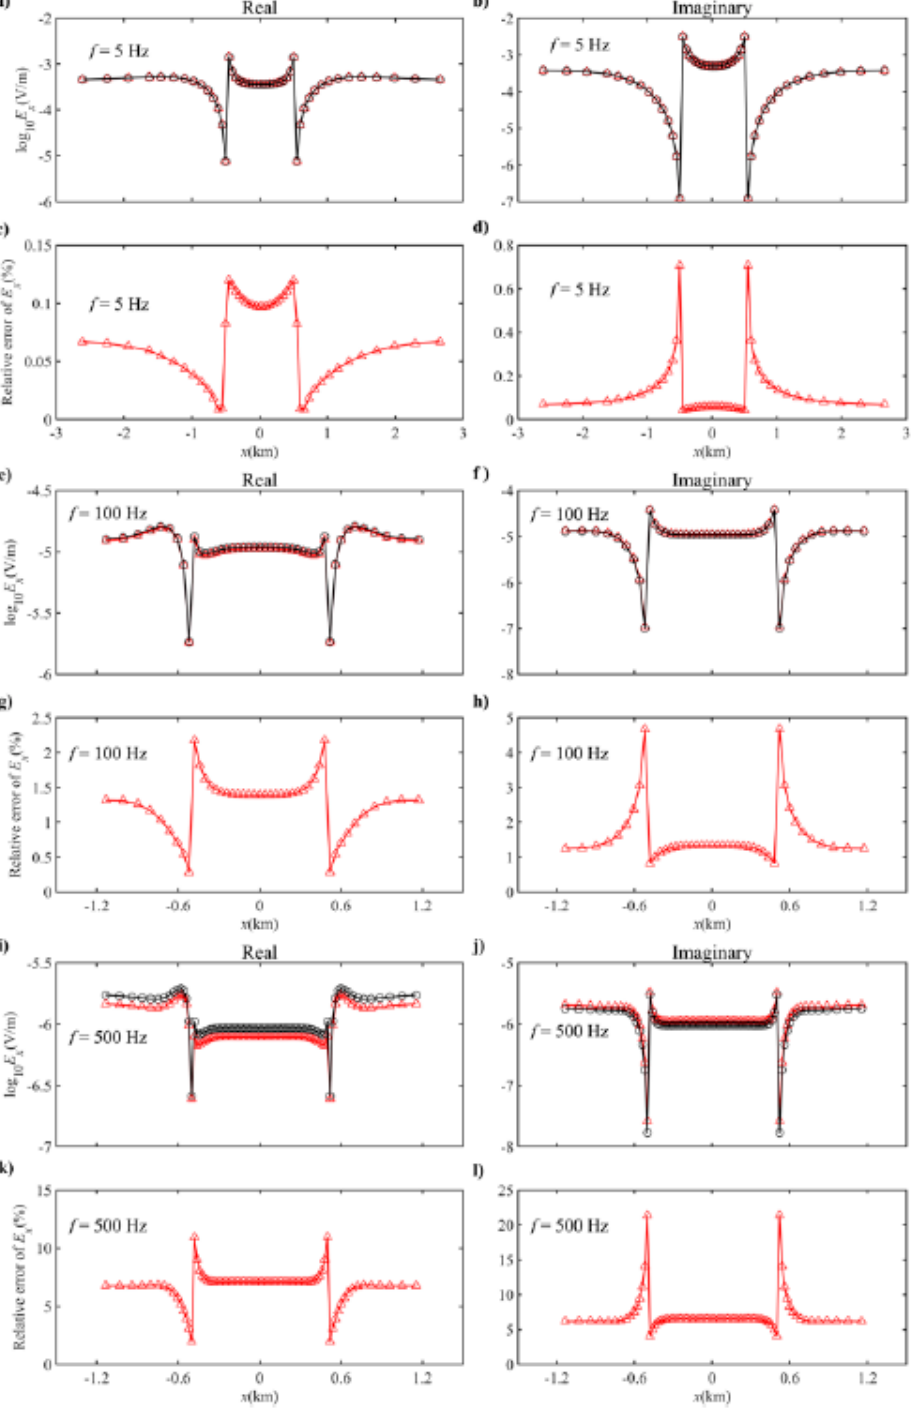
Figure 7. Comparison of the E x numerical solutions from the case based on the quasi-static approximation (upward-pointing triangle lines)) with 10 − 6 S / m for air conductivity, and the one with the complete wavenumber (circle lines) at frequencies of ( a – d ) 5 × 10 0 , ( e – h ) 10 2 , and ( i – l ) 5 × 10 2 Hz for the canyon model. The relative errors are referenced to the results based on the use of the complete wavenumber.